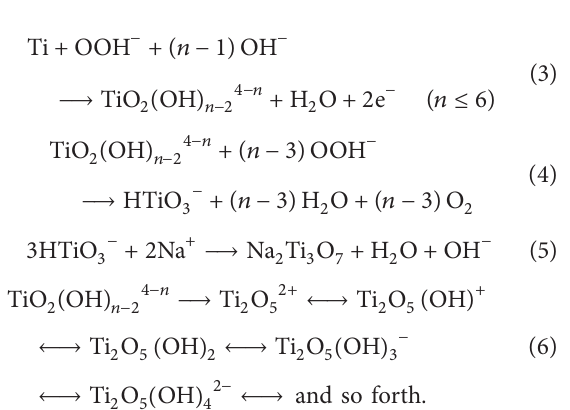
Figure 9: Pseudo-first-order kinetic plots for NR, MB, MG, and